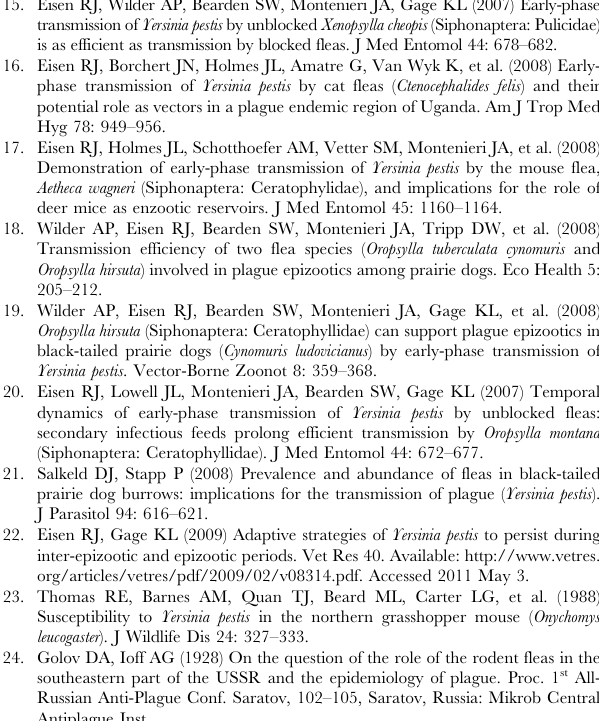
Figure S1 Flow chart for the host sub model. The three transmission routes included in the model are highlighted: booster-